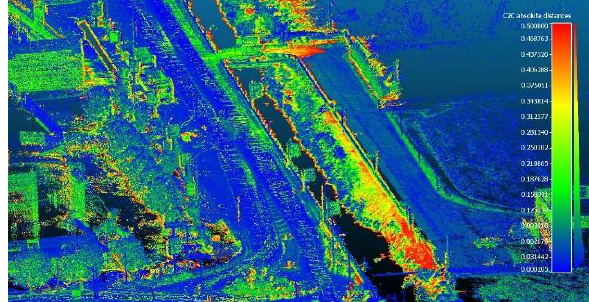
Figure 15. Comparison of point clouds between the real-time solution of the Stencil 2 and the photogrammetry model, related Via Sant’Eufemia